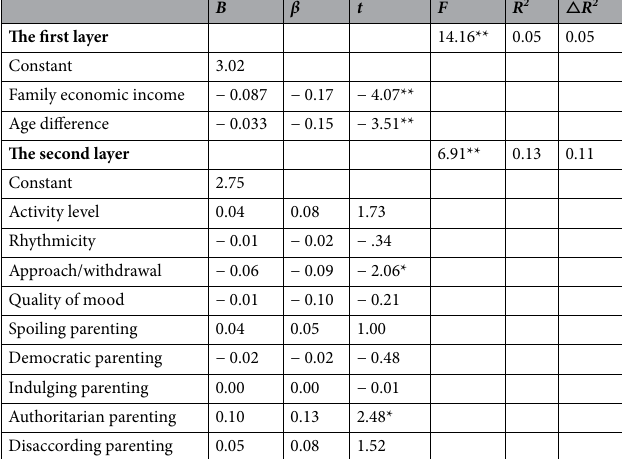
Table 2. A hierarchical multiple regression analysis. * p < 0.05, ** p < 0.01.